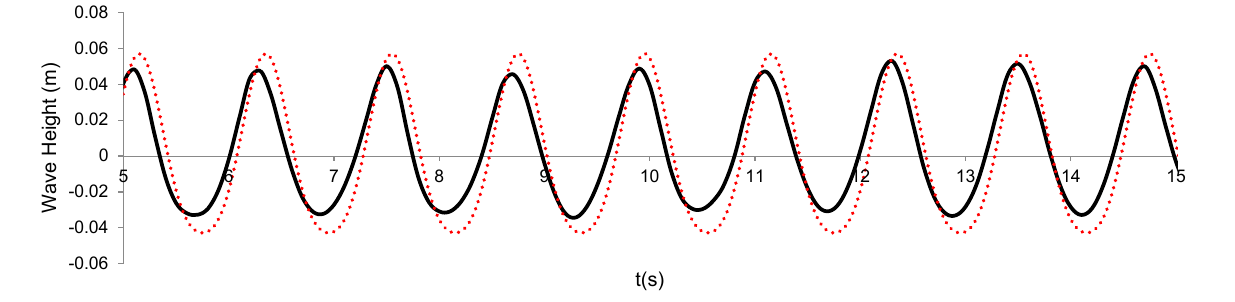
Figure 3. DualSPHysics model validation using analytical theory. The distance of particles is 0.02 m, and the simulation duration is 20 s. The black line shows the measurement of the numerical simulations, while the dotted line illustrates the analytical theory.